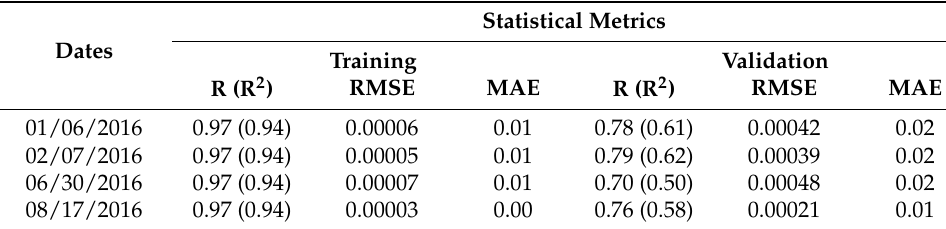
Table 1. Summary statistics of the prediction algorithms.